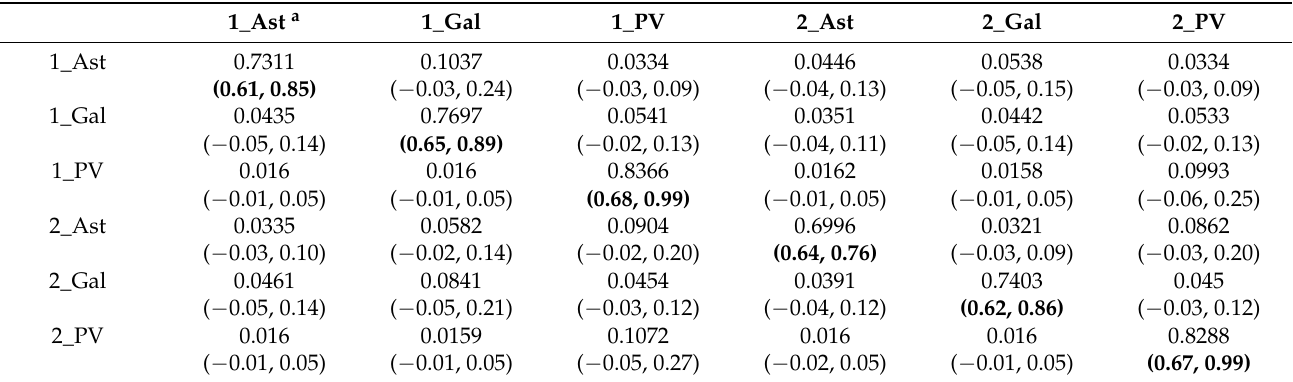
Table 7. Migration rate means (and 95% confidence interval) within and among subpopulations a of Spanish Fusarium circinatum defined in a temporal scale and by geographic origin, as estimated using Bayesass